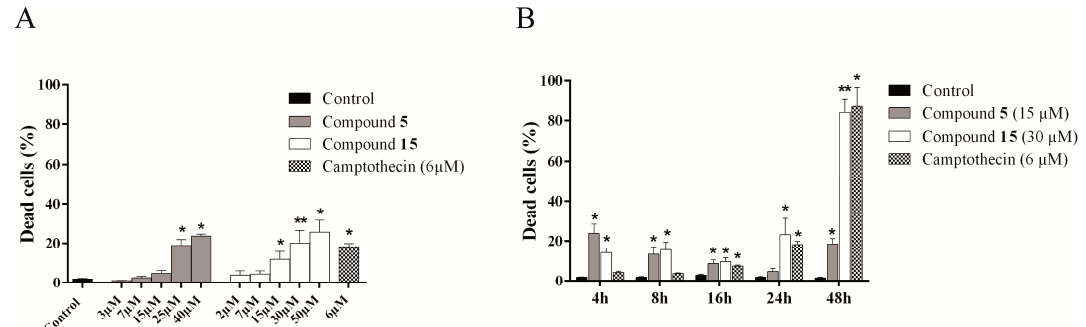
Figure 5. Cell death induction is dose and time-dependent for compound 15 in MCF7. MCF7 cells were treated with vehicle (control) or increasing doses of compound 5 or 15 for 24 h. For the time-course experiment, MCF7 cells were treated with vehicle (control), compound 5 (15 µ M) or compound 15 (30 µ M) for different times. Camptothecin (6 µ M) was included as positive control. Cells were stained with the Apo-Direct kit (TUNEL assay) and analyzed by flow cytometry. ( A ) Dose-dependent cell death at 24 h; ( B ) Time-course analysis of cell death. Results show the mean ± SEM of at least three independent experiments performed in duplicate. * p < 0.05, ** p < 0.01.